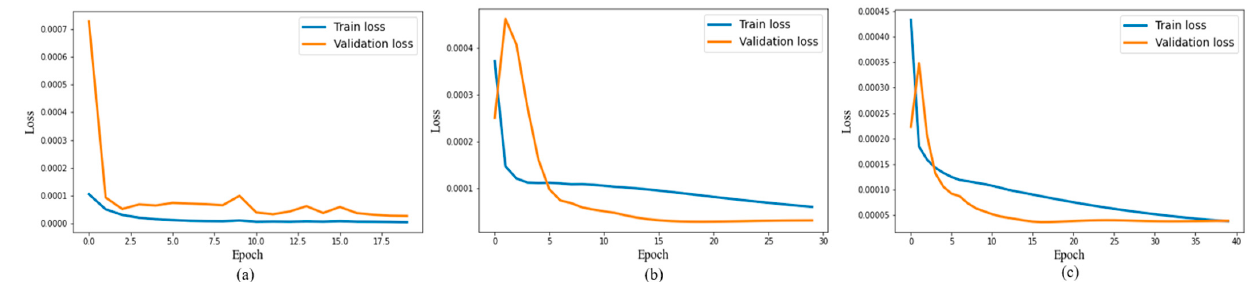
Electronics 2021 , 10 , x FOR PEER REVIEW